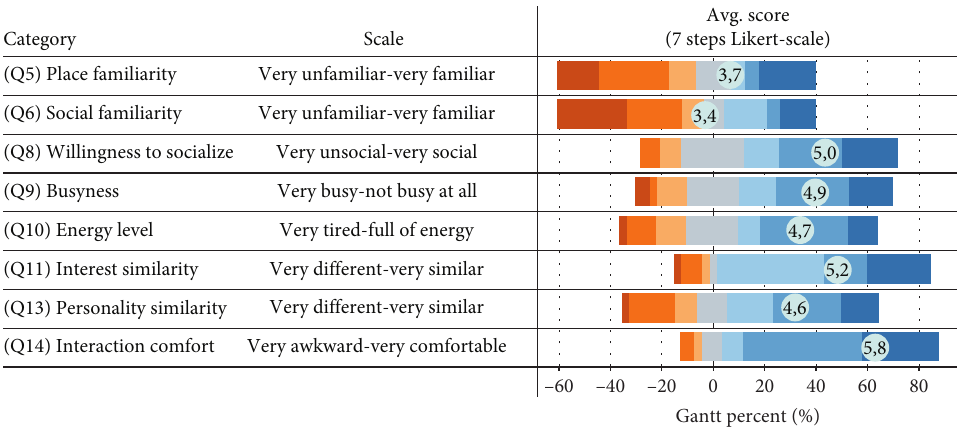
Figure 3: Attributes of the respondents’ serendipitous social